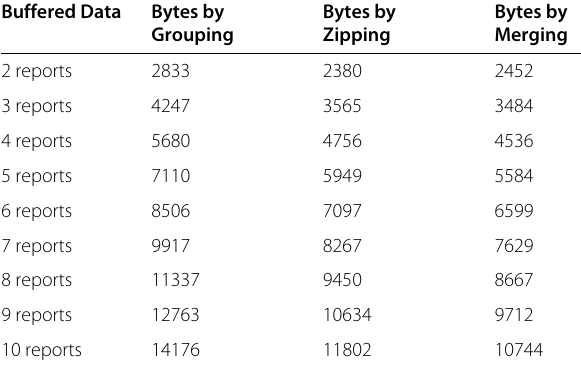
Table 7 Overall Data Sizes (in Bytes) with Different Buffering Strategies Buffered